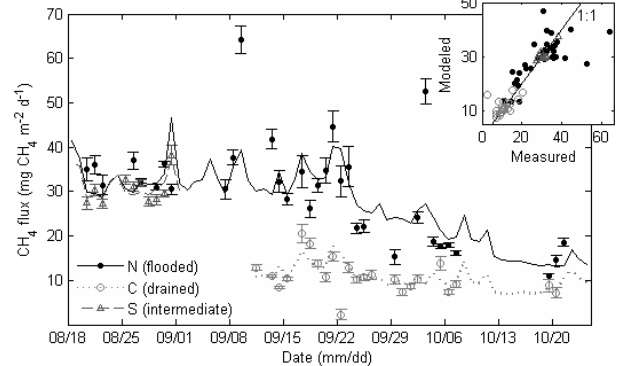
Fig. 7. Measured daily average CH 4 fluxes (points) along with mod- Figure 7. Measured daily average CH 4 fluxes (points) along with modeled fluxes derived 2 eled fluxes derived from multiple regression results (lines). The in- from multiple regression results (lines). The inset plot compares measured and modeled 3 set plot compares measured and modeled fluxes to a 1:1 relationship fluxes to a 1:1 relationship (North model R 2 =62%, p < 0.001; Central model R 2 =60%, p < 4 (North model R 2 = 62%, p < 0 . 001; Central model R 2 = 60%, 0.001, South model R 2 =58%, p = 0.01). 5 p < 0 . 001, South model R 2 = 58%, p = 0 .